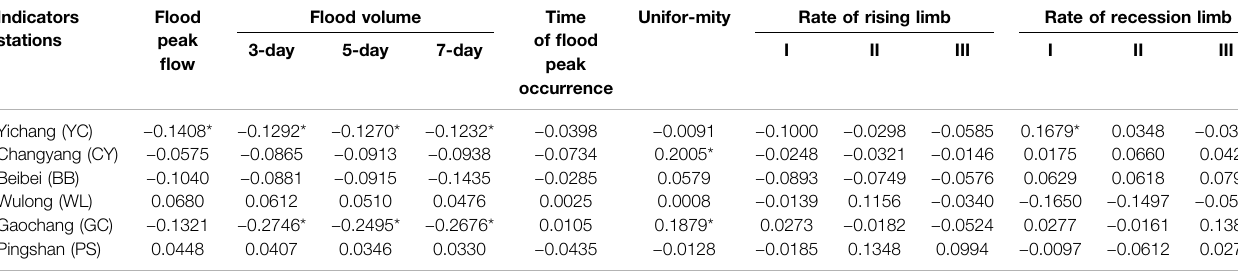
TABLE 5 | Kendall ’ tau statistic of evaluation indicators at the six stations in the UYR by zyp.zhang. Indicators